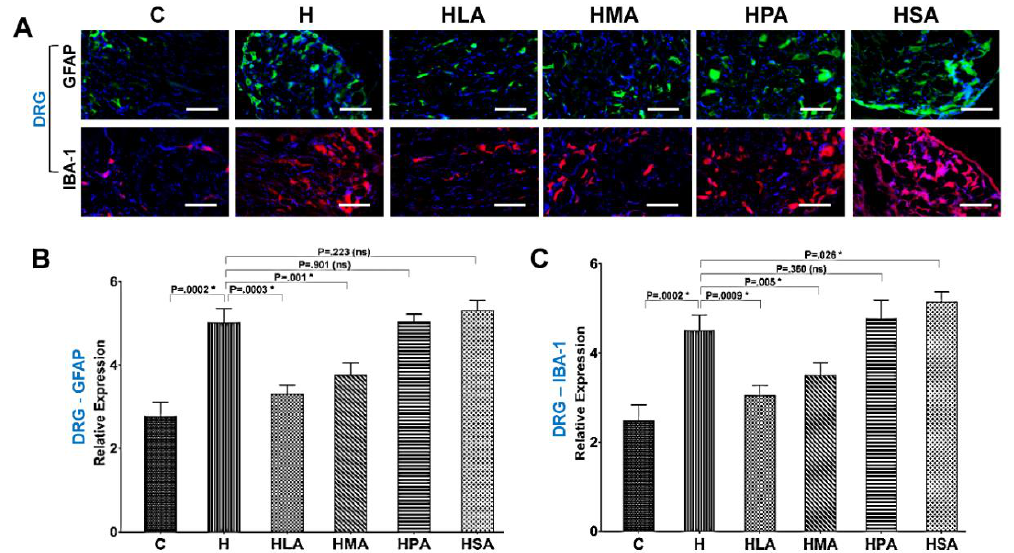
Figure 6. Glial cell activation in dorsal root ganglia (DRG). (A) Typical dorsal sections of the DRG showing astrocyte (GFAP—astrocyte marker) and microglia (IBA-1—Microglia marker) activation in OA rats fed the different diets. Quantification of GFAP (B) and IBA-1 (C) mRNA levels in the DRG was performed using qPCR. All values are represented as mean ± SD, n = 4. C, corn starch diet-fed rats; H, high-carbohydrate high-fat diet-fed rats; HLA, high-carbohydrate high-lauric acid diet-fed rats; HMA, high-carbohydrate high-myristic acid diet-fed rats; HPA, high-carbohydrate high- palmitic acid diet-fed rats; HSA, high-carbohydrate high-stearic acid diet-fed rats. 4. Discussion OA is both an age- and mechanical- stress-related degenerative joint disease as well as a metabolic disease with independent effects of diabetes, dyslipidaemia and hypertension to cartilage degradation [3,22]. Animal models of OA may provide evidence for mechanisms of OA and possible interventions but there is no single, widely-accepted animal model [23]. Surgical models in rats produce joint instability, altered joint mechanics and local inflammation; these models are reproducible with rapid onset and progression which may not fully mimic human OA [23]. Non- invasive monitoring with magnetic resonance imaging of the femorotibial joint in rats following partial medial meniscectomy showed progressive changes in cartilage related to trauma-induced OA [24]. More commonly, OA is induced in rats by injection of monosodium iodoacetate into the knee or ankle joint [25]; however, this intervention produces chondrocyte death rather than trauma-induced cartilage degeneration in OA. Pain is a major characteristic of human knee OA, so measurement of pain in rat models of OA is essential for translation to humans. The advantages and disadvantages of the methods used in this project (von Frey, hind limb grip strength and mechanical pain threshold of the knee joint) have been reviewed [26–28]; none are perfect matches to human OA pain, but they are widely accepted as appropriate methods for use in rodents, for example in the testing of analgesics [29]. Chronic low-grade inflammation in obesity may worsen the damage and pain in OA [13,14]. Obesity-induced osteoarthritis in the knee can be modelled by surgery on rats with diet-induced obesity [30]. Abdominal obesity is part of metabolic syndrome, together with hypertension, hyperglycaemia, fatty liver, and inflammation, which increases the risk of cardiovascular disease and diabetes; this syndrome is mimicked by a diet high in simple sugars, and saturated and trans fats in